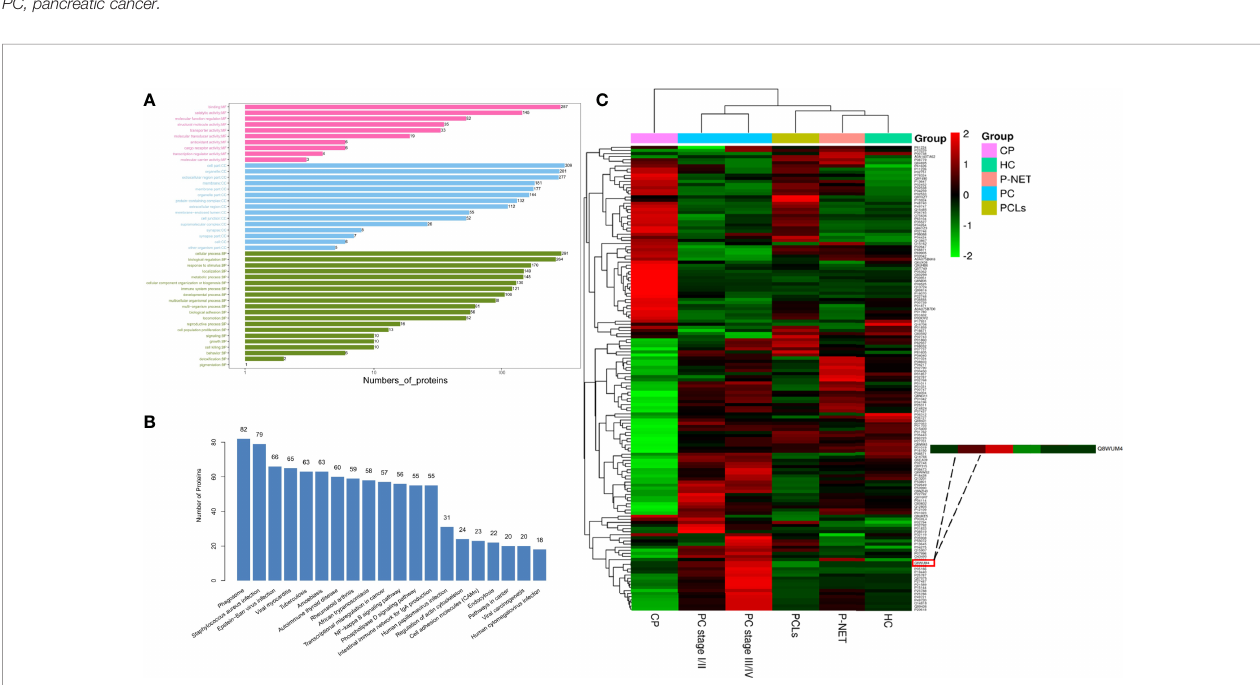
FIGURE 4 | Biological function and quantitative evaluation of plasma-derived exosomal proteins. (A) Gene ontology (GO) classi fi cation of whole identi fi ed exosomal proteins. The enriched terms in the biological process, cellular component, and molecular functions were listed. (B) Kyoto Encyclopedia of Genes and Genomes (KEGG) pathway analysis of whole identi fi ed exosomal proteins. The top 20 enriched pathways in exosomes were listed. (C) Hierarchical clustering heat maps of 150 important proteins, which were identi fi ed by t-test. The expression of each protein was illustrated in red and green to indicate high and low expression,